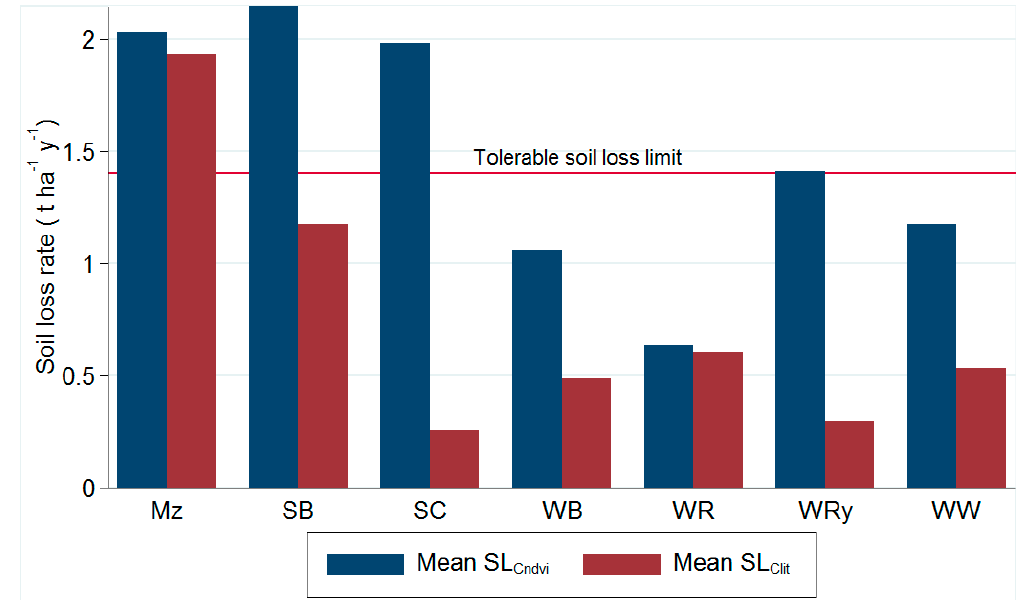
Figure 5. The three-year average annual potential soil erosion rates computed using C ndvi (SL cndvi ) and C lit (SL clit ).